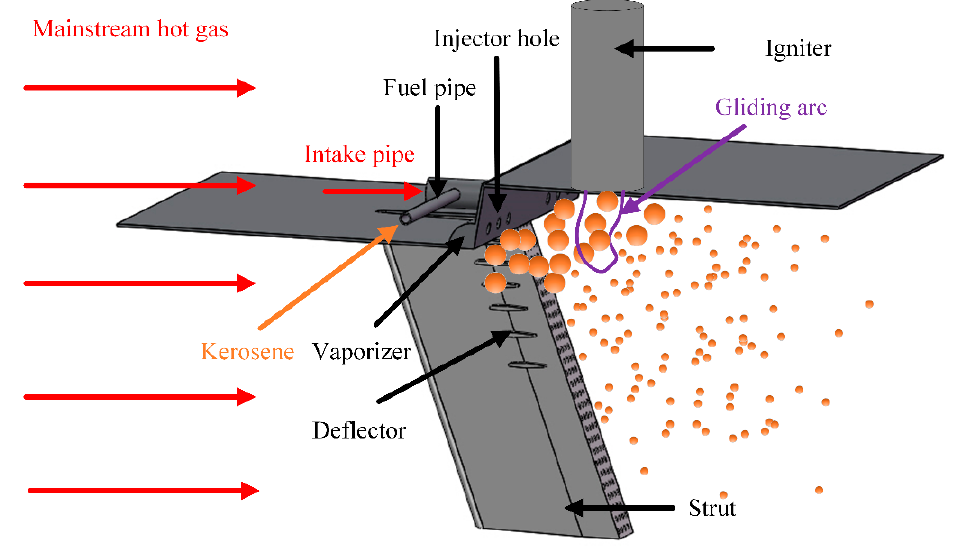
Figure 4. Hyperburner-integrated flameholder structure.